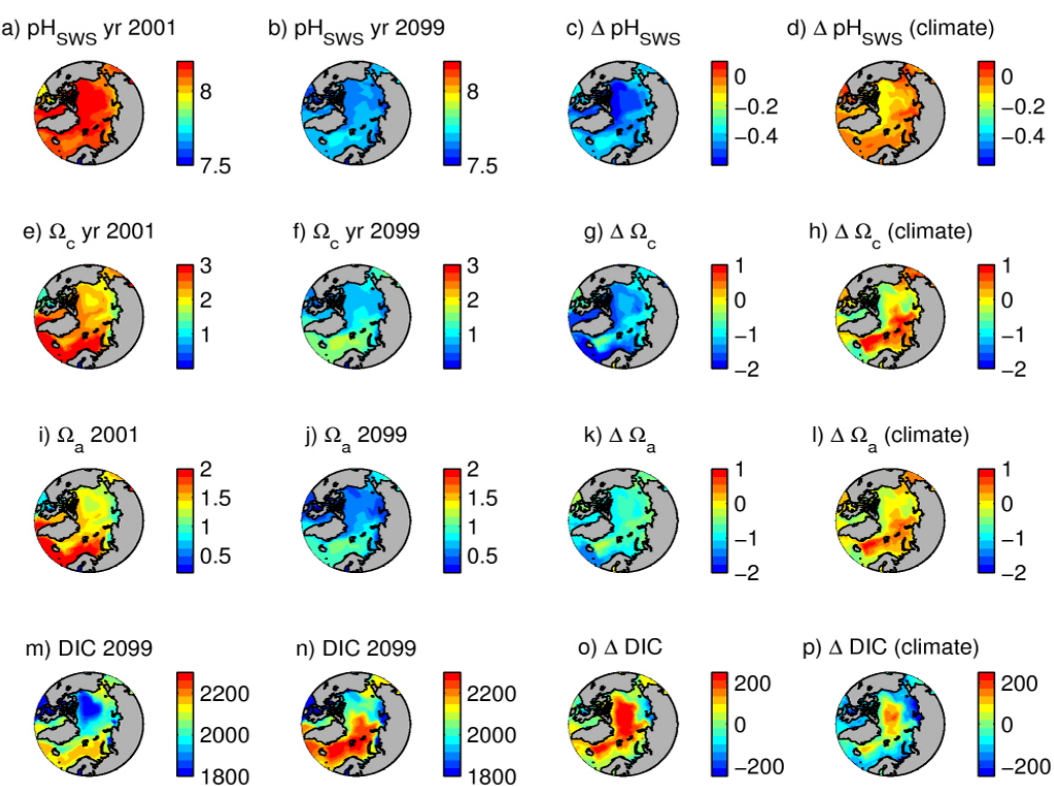
Fig. 4. Arctic Ocean pH SWS (a–d) , (cid:127) c (e–h) , (cid:127) a (i–l) , DIC (mmolm − 3 , m–n ). The first and second columns shows values for year 2000 and 2099 respectively, the third column shows deviation between year 2099 and year 2000 for the full run, and the fourth column shows deviation between year 2099 and year 2000 for the for the climate change